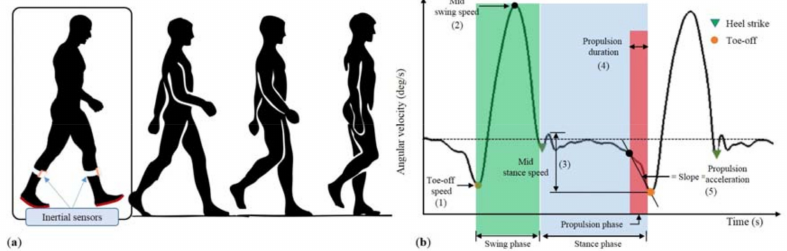
Figure 1. ( a ) Two wearable inertial sensors (LEGSysTM, BioSensics LLC) were attached to the left and right lower shin of the participant during a single walking task. The propulsion phase happens toward the end of the stance phase of the gait cycle. It is segmented between heel-off and toe-off. ( b ) Typical angular velocity profile of gait cycle in the sagittal plane derived from the inertial sensor during single walking task. The definition of each gait parameters are detailed in Table 1.